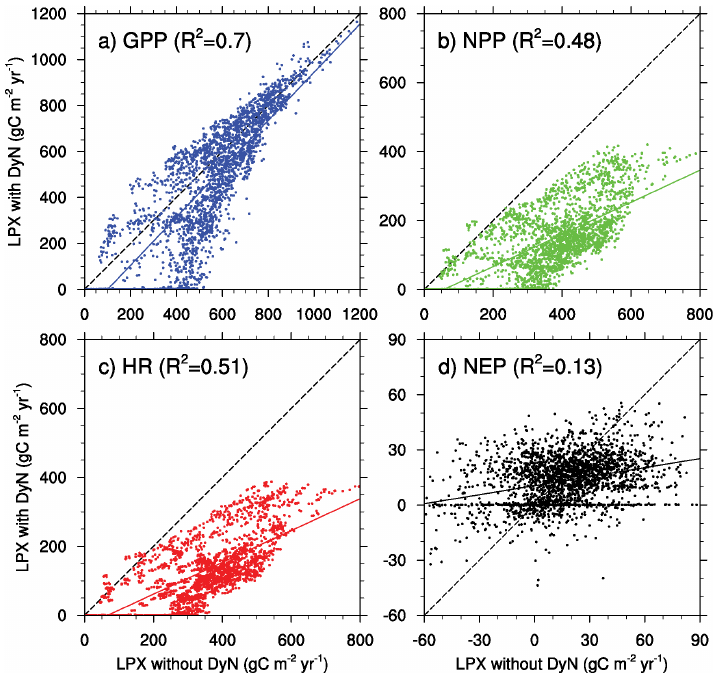
Fig. 6. Comparison of (a) gross primary production, (b) net primary production, (c) heterotrophic respiration and (d) net ecosystem produc- tion in northern high-latitude peatlands for LPX simulations with and without dynamic N cycle (DyN). Each point represents a 10yr average. Solid lines are linear fits through points ( R 2 , coefficient of determination, is given in the headers) and dashed lines represent the 1:1